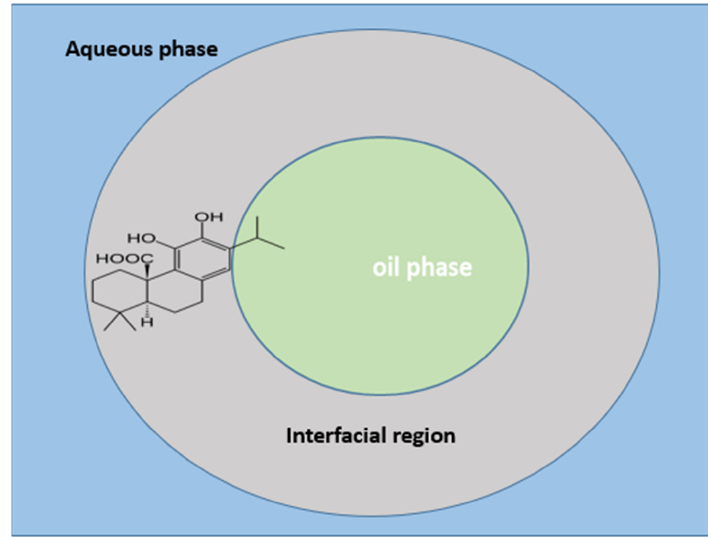
Figure 1. Expected partitioning of phenolic antioxidants between the different regions of an o/w emulsion system (alkyl chain towards the lipid core, hydrophilic part towards the interface).